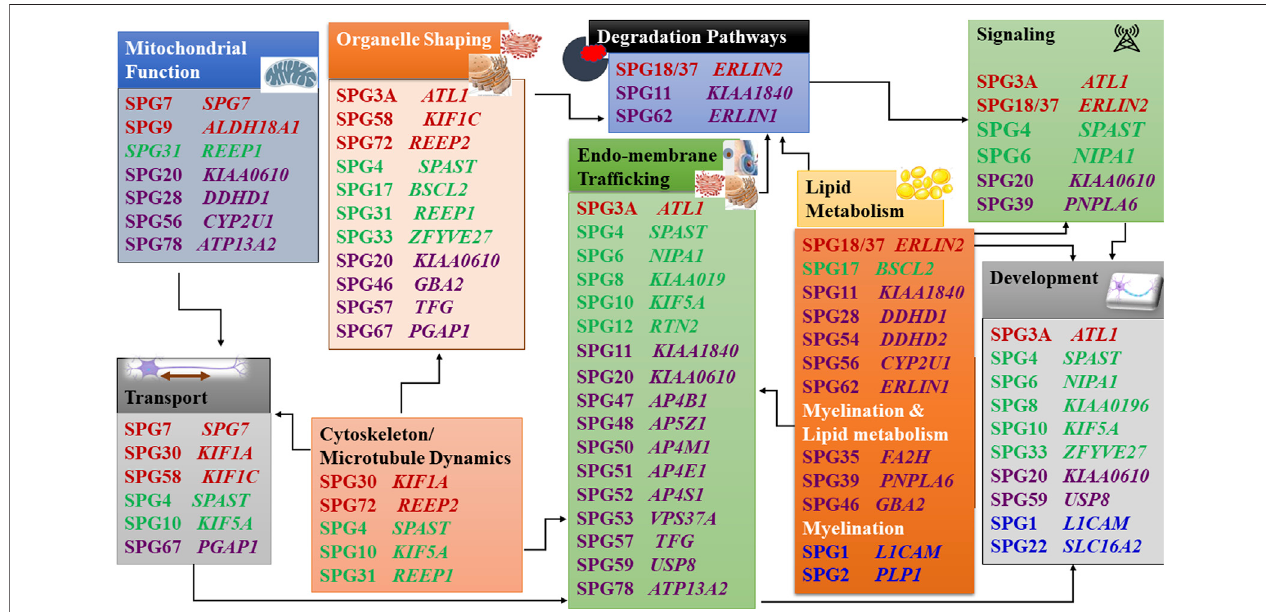
FIGURE 3 | Intersections of HSP pathogenetic mechanisms highlighting the interplay between pathways. Font color codes correspond to various patterns of inheritance: AD HSP (green), AR HSP (violet), X-linked recessive (Blue), and Mixed AR/AD inheritance (red).